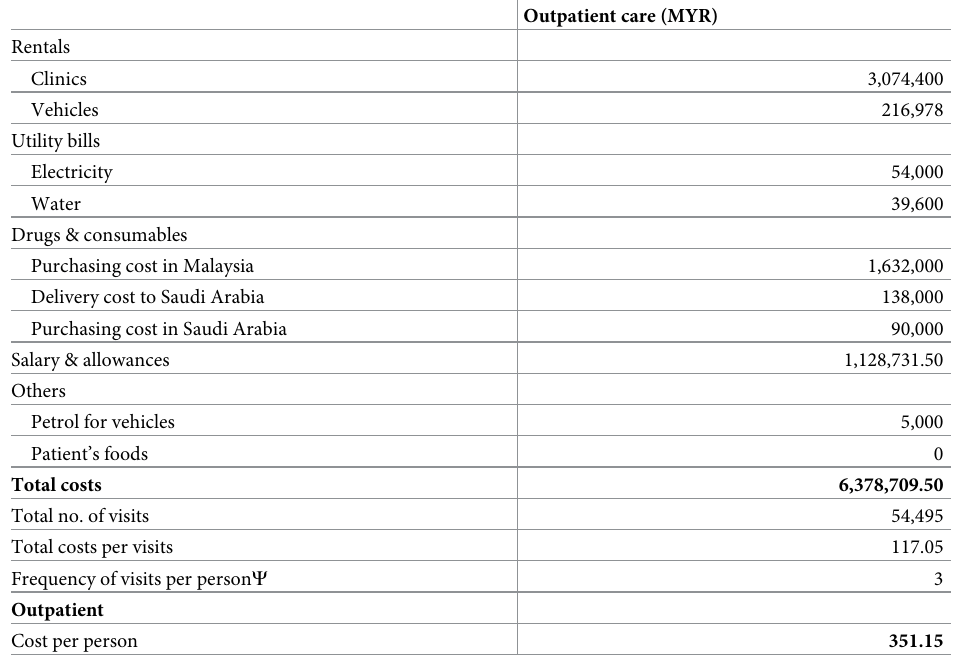
Table 2. Costs estimate per year for outpatient care to treat pneumococcal disease based on actual expenditures in